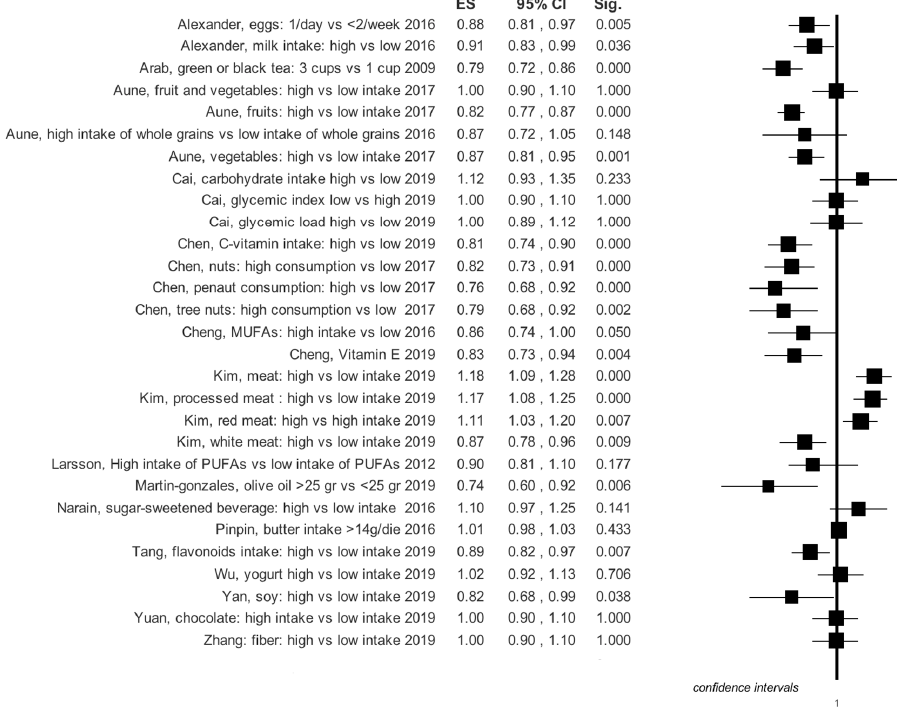
Figure 4. Summary results of effects size for any type of stroke events in RCT, based on study design of selected primary studies for each meta-analysis.